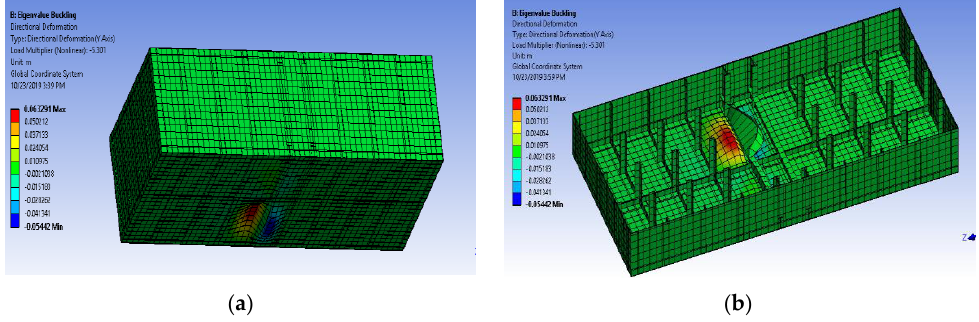
Figure 18. Eigen value buckling analysis. ( a ) Isometric view of the buckling failure, ( b ) Horizontal section illustrates the buckling of the internal sti ff